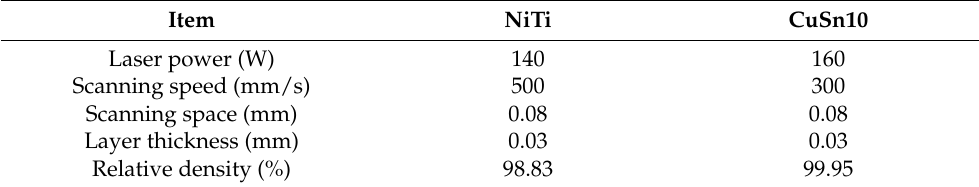
Table 4. Optimum SLM process parameters of NiTi alloy and CuSn10